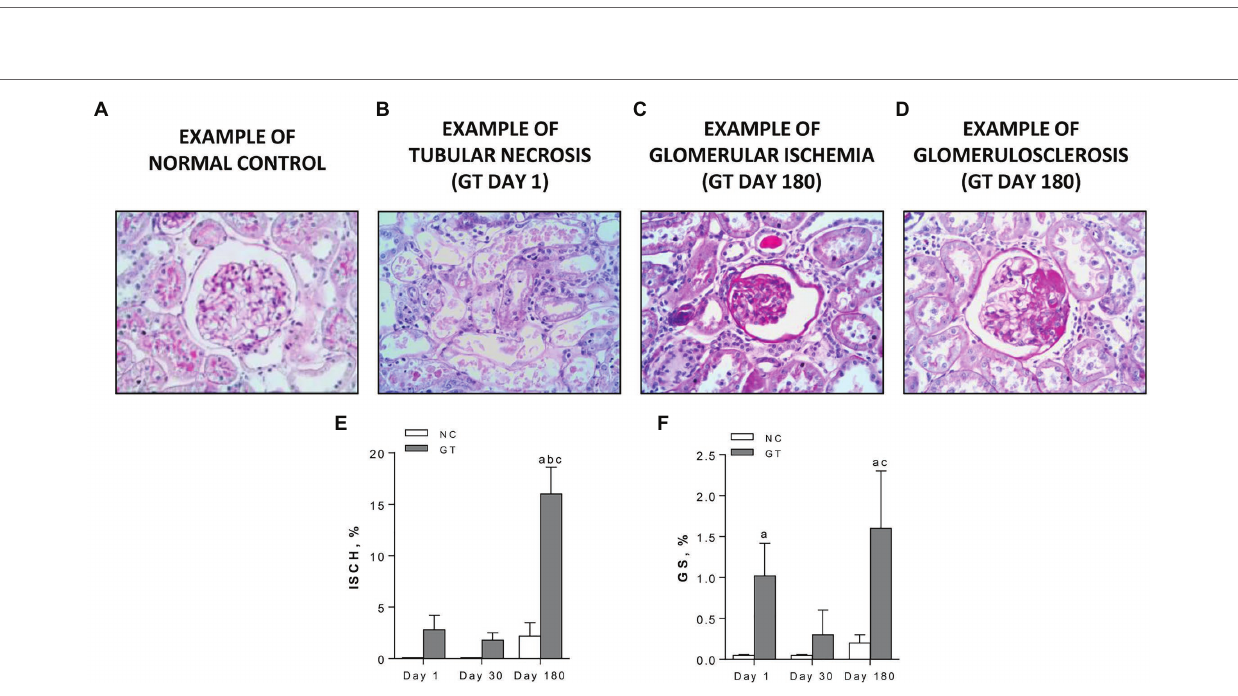
FIGURE 2 | Serum concentration (A) and fractional excretion (B) of sodium; serum concentration (C) and fractional excretion (D) of potassium; and urinary osmolality (E) and renal content of KIM-1 (F) . Results expressed as means ± SE . a p < 0.05 vs. NC; b p < 0.05 vs. Day 1; c p < 0.05 vs. Day 30.